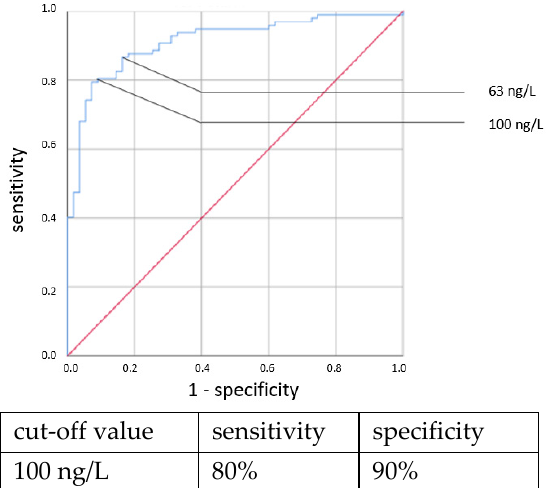
Figure 4. IL-6 concentration. Clinical LOS.